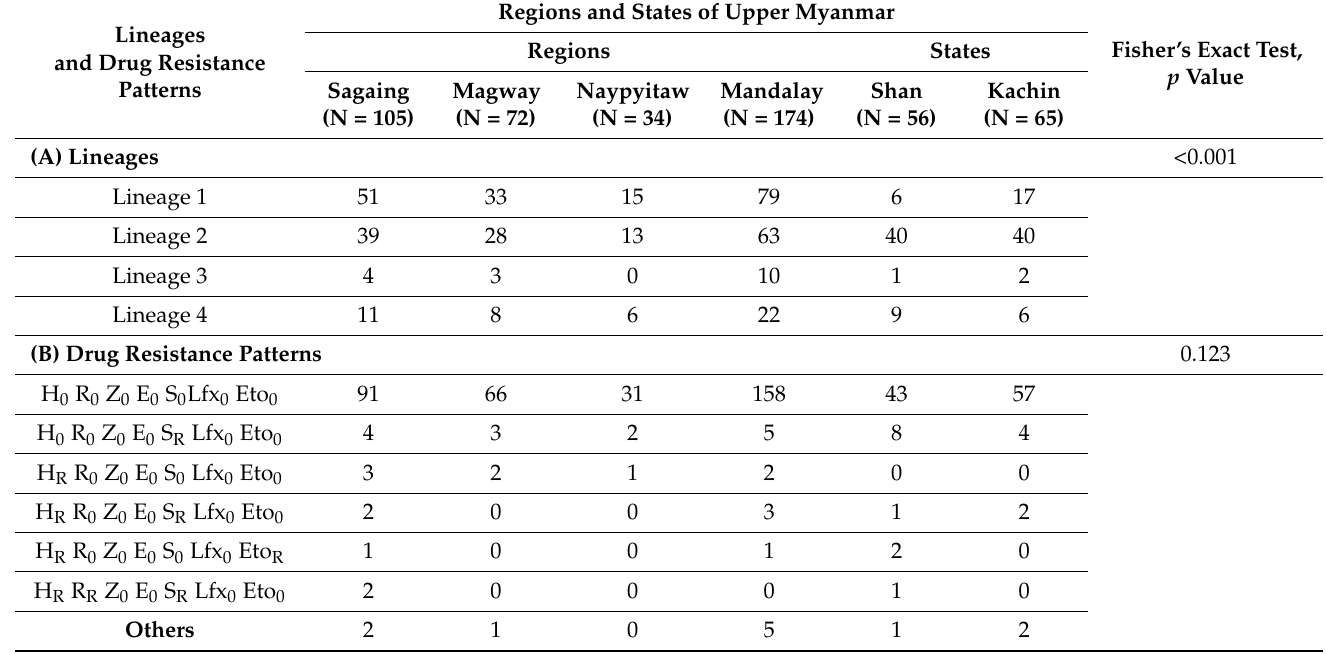
Table 6. Geographical distribution of lineages and drug resistance